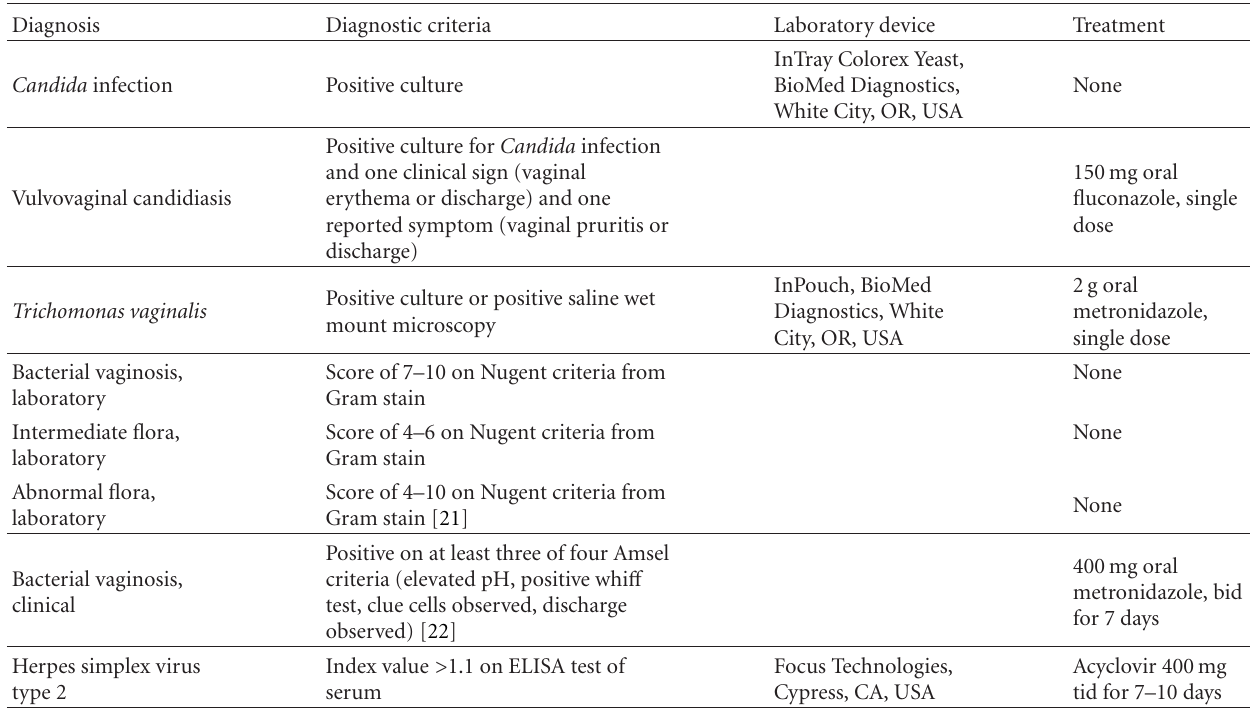
Table 1: Diagnostic criteria and treatment given for laboratory- and clinically-diagnosed gynecological conditions, Mysore, India